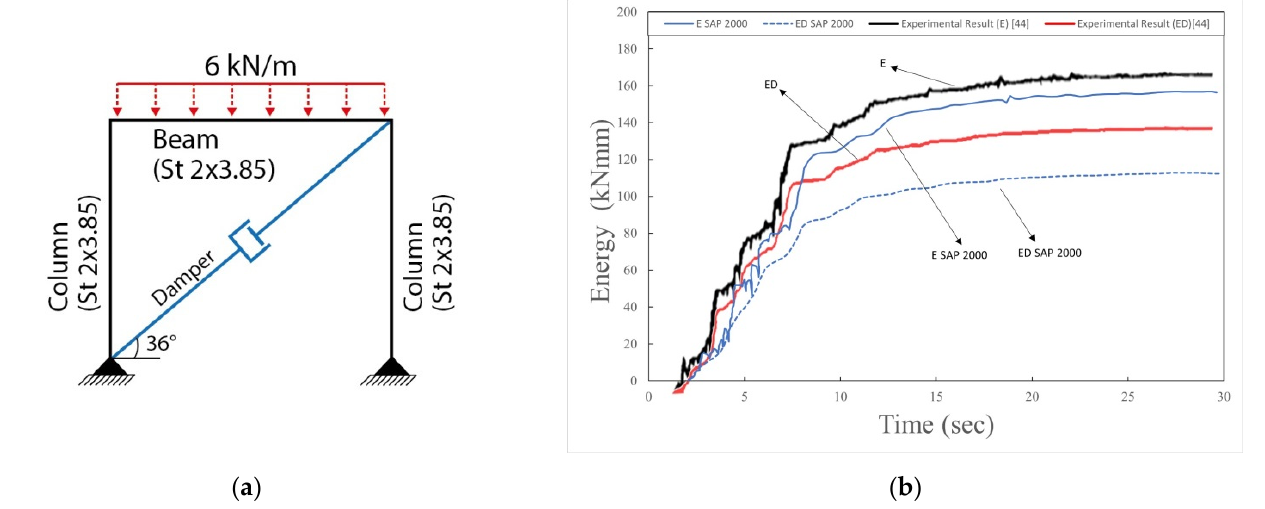
Figure 6. ( a ) Geometry of the VD testing frame (Adapted with permission from [44,51]) and ( b ) Verification of SAP 2000 model against the experimental results of VD.